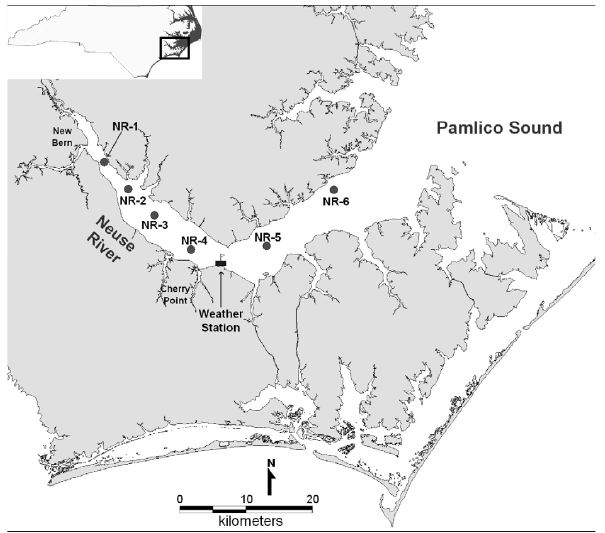
Fig. 2. Sampling locations in the Neuse River Estuary were selected Figure 2 over various salinities, ranging from oligohaline to mesohaline en- vironments. Stations are numbered with the lowest number (NR-1) upriver, increasing sequentially down-estuary.